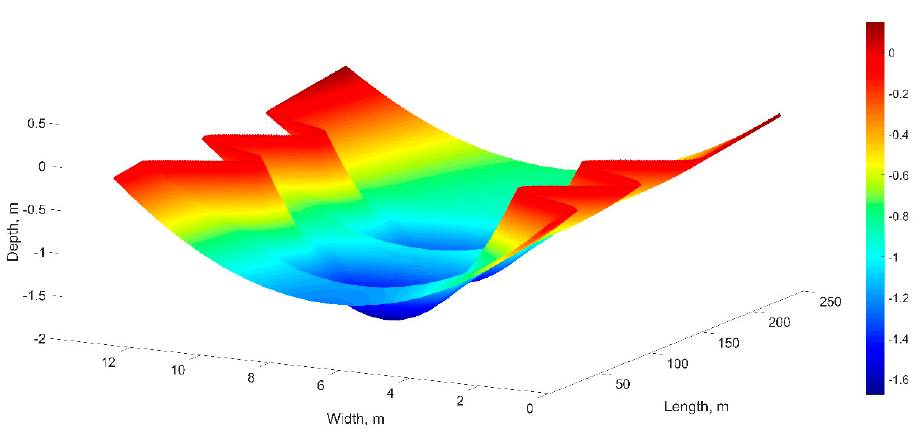
Figure 1. Results of the synthetic bathymetry corresponding to scenario 1.